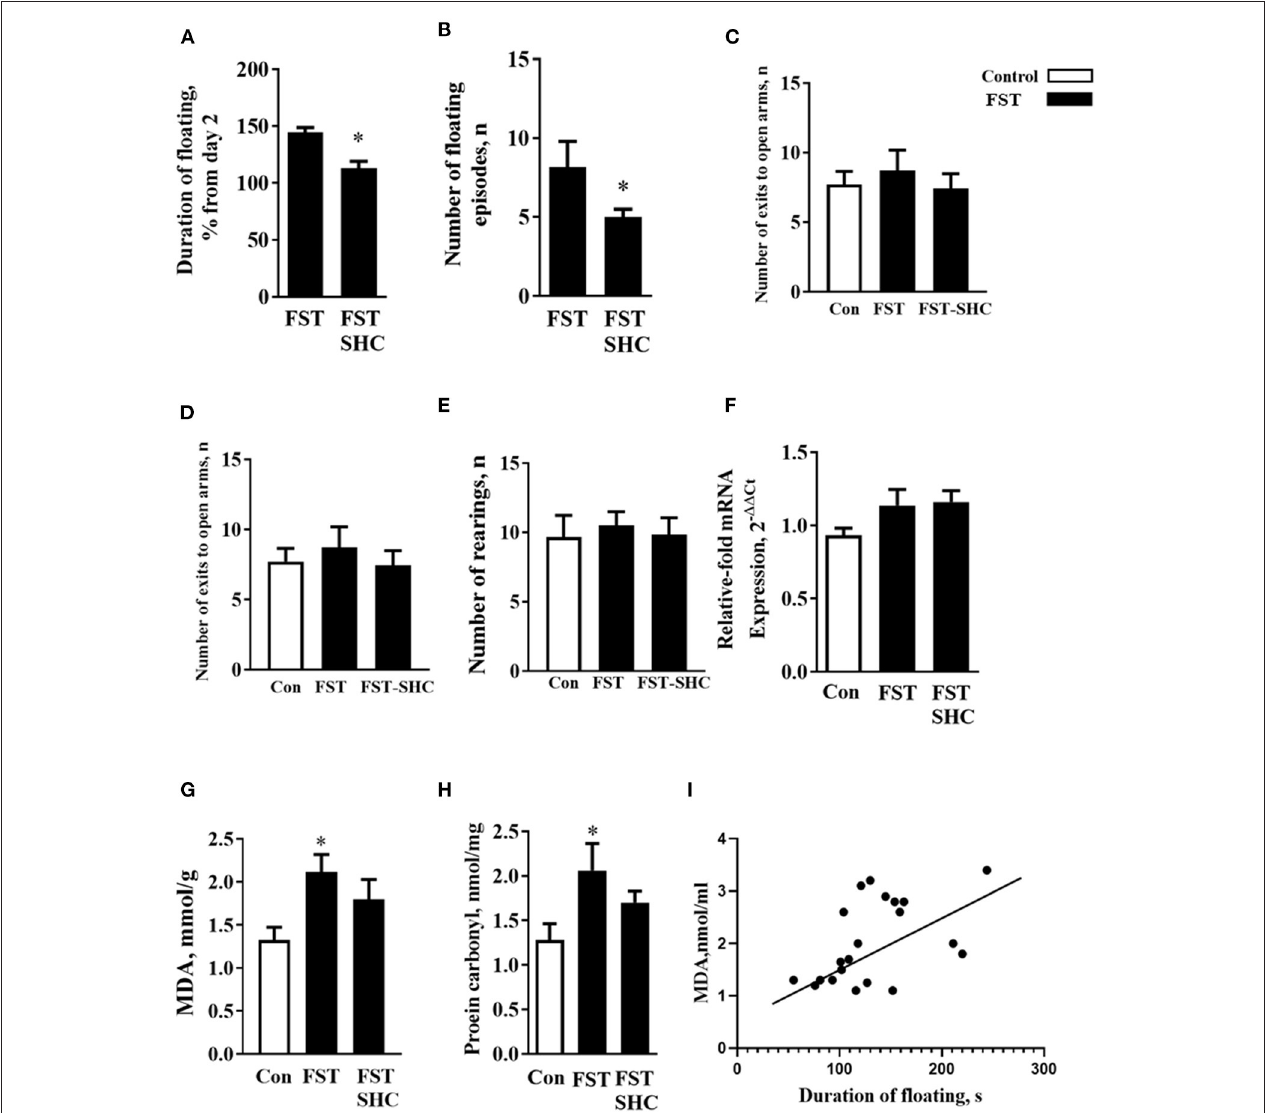
FIGURE 4 | Oxidative stress and helplessness in the modFST are counteracted by herbal antioxidant treatment in C57BL/6 mice. In comparison to nontreated animals, (A) the duration of floating and (B) the number of floating episodes on day 5 normalized to day 2 were significantly lower in the SHC-treated mice; thus, the latter group showed a reduced potentiation of floating behavior by the end of repeated testing in the modFST. Mice exposed to the modFST revealed no significant differences in the (C) number of exits in the O-maze, (D) time spent therein, and (E) number of rears in the open field. (F) A three-group comparison that additionally included control naïve swimming mice revealed no significant group differences for mRNA GSK-3 β concentrations but for normalized brain MDA concentration. (G) This measure was significantly higher in nontreated modFST-exposed animals than in those naïve for modFST. No such increase was shown by the SHC-treated modFST group, which had significantly lower MDA concentrations than the nontreated modFST-exposed group. (H) The level of protein carbonyl was increased in the nontreated modFST mice but not in the SHC-treated animals. (I) Significant correlation was found between the duration of floating on day 5 and MDA concentrations (Pearson correlation). * p < 0.05 vs. nontreated controls, t -test, or one-way ANOVA and Tukey’s test ( see the ms text ). Bars are mean ±